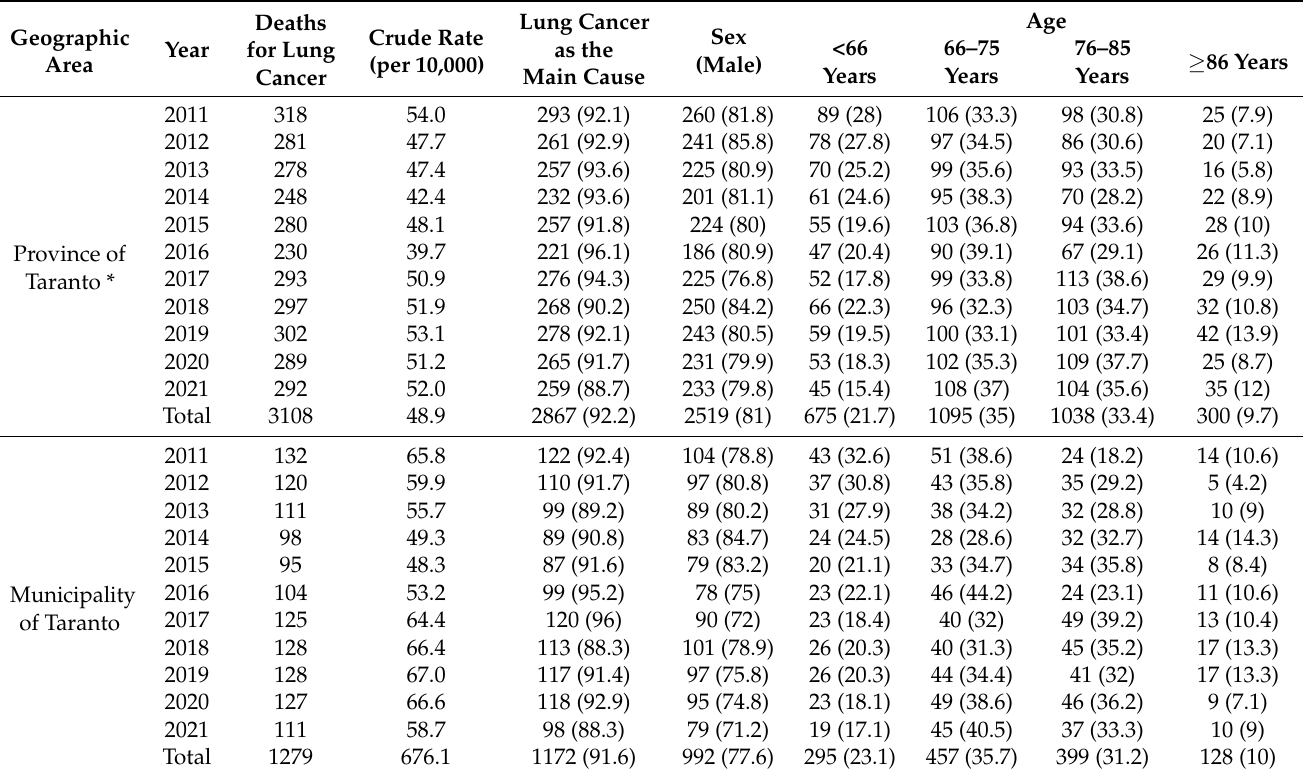
Table 1. Main characteristics of lung cancer deaths recorded in the province of Taranto and in the municipality of Taranto between 2011 and 2021.